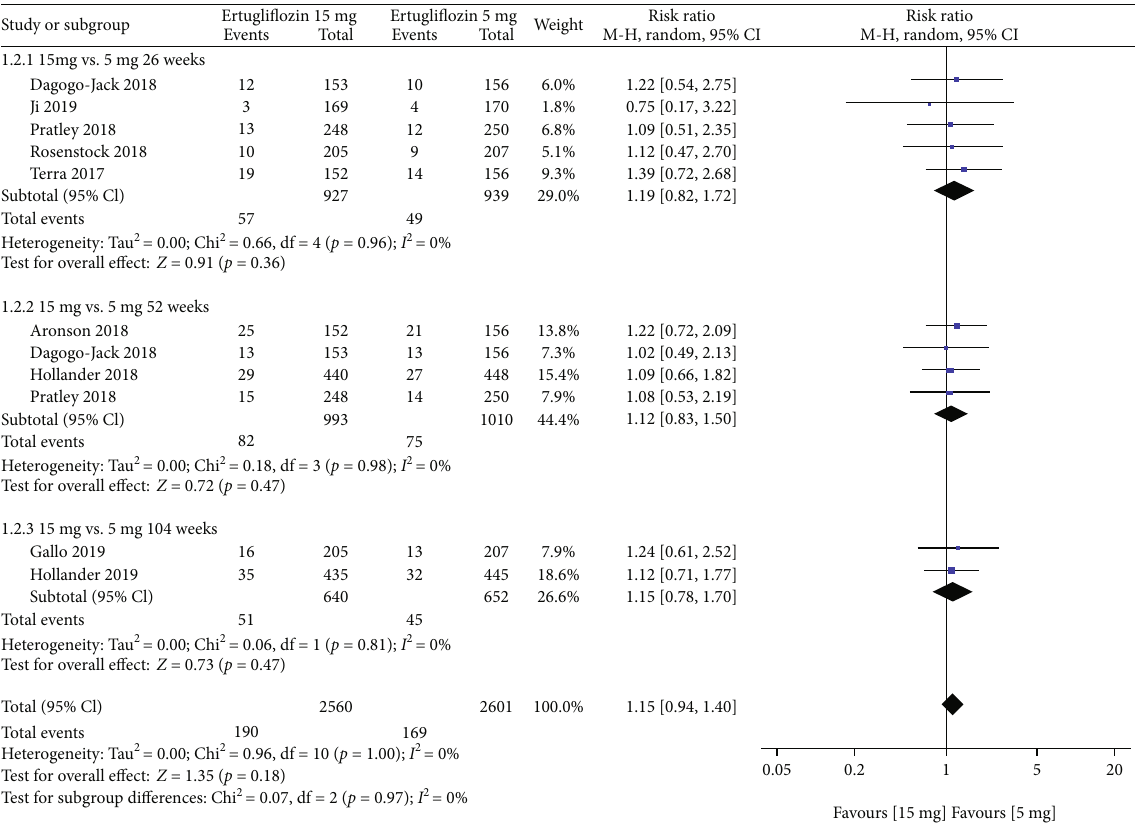
Figure 7: Forest plot of the risk of GMIs when comparing ertugli fl ozin 15 mg with 5mg at 26, 52, and 104 weeks. CI: con fi dence interval; M- H: